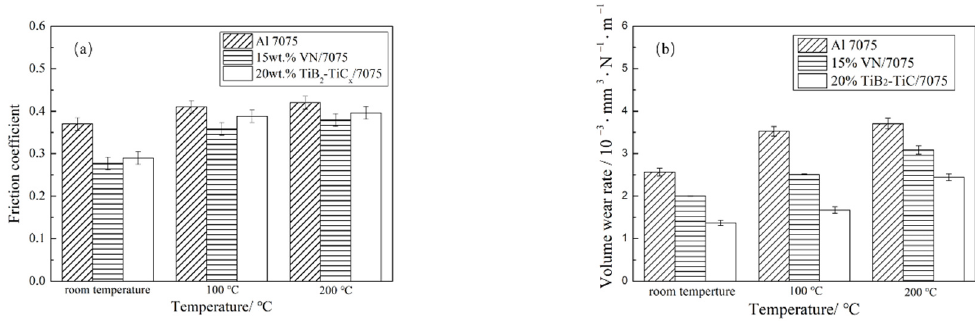
Figure 4. Friction coefficient and wear rate of samples after wear test at different temperatures. ( a ) friction coefficient; ( b ) wear rate.